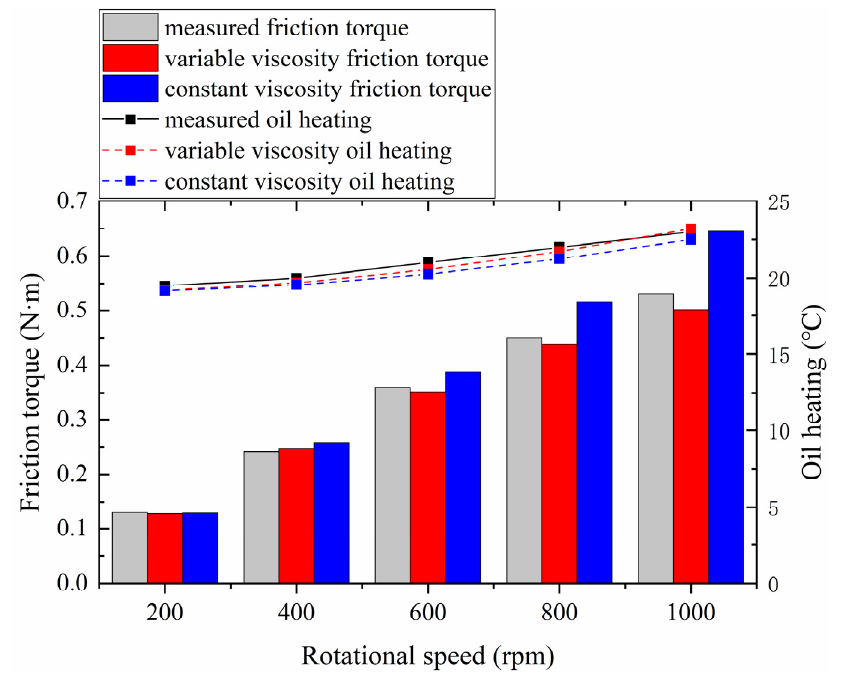
Figure 12. Comparison of the experimental friction torque and oil heating of hydrostatic lead screw with their estimation.